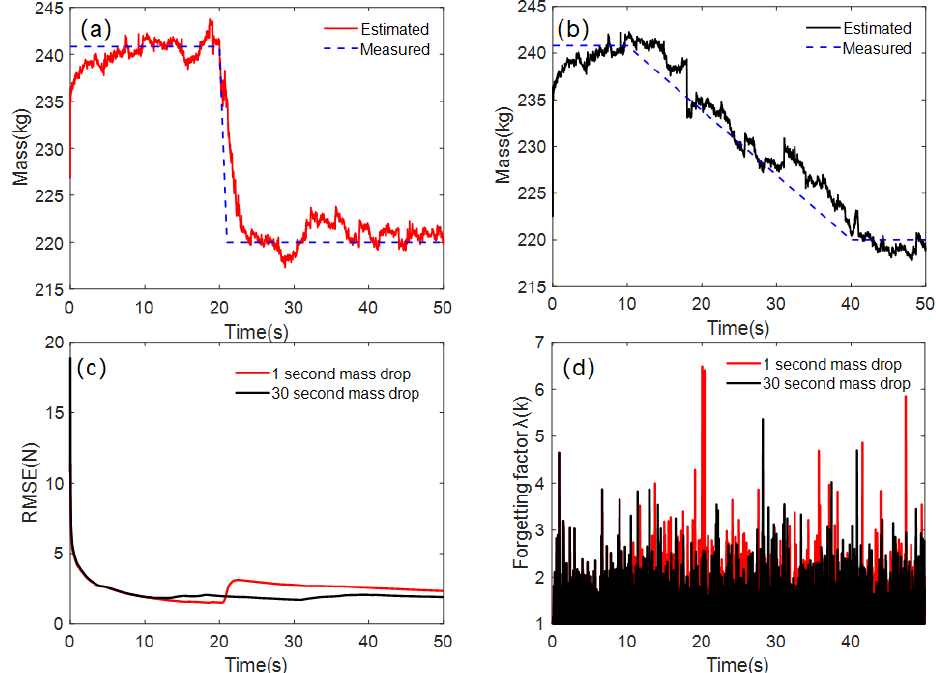
Figure 13. Experimental result of vehicle mass estimation ( a ) estimated vehicle mass (240 kg → 220 kg from 20 to 21 s), ( b ) estimated vehicle mass (240 kg → 220 kg from 10 to 40 s), ( c ) RMSE according to mass drop rate, and ( d ) forgetting factor according to mass drop rate.